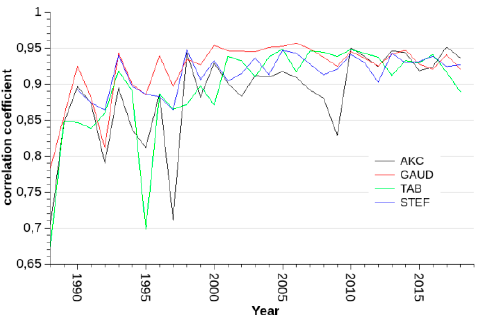
Figure 1. Correlation coefficients between the stations and Belgradplatz (BELG) per year.